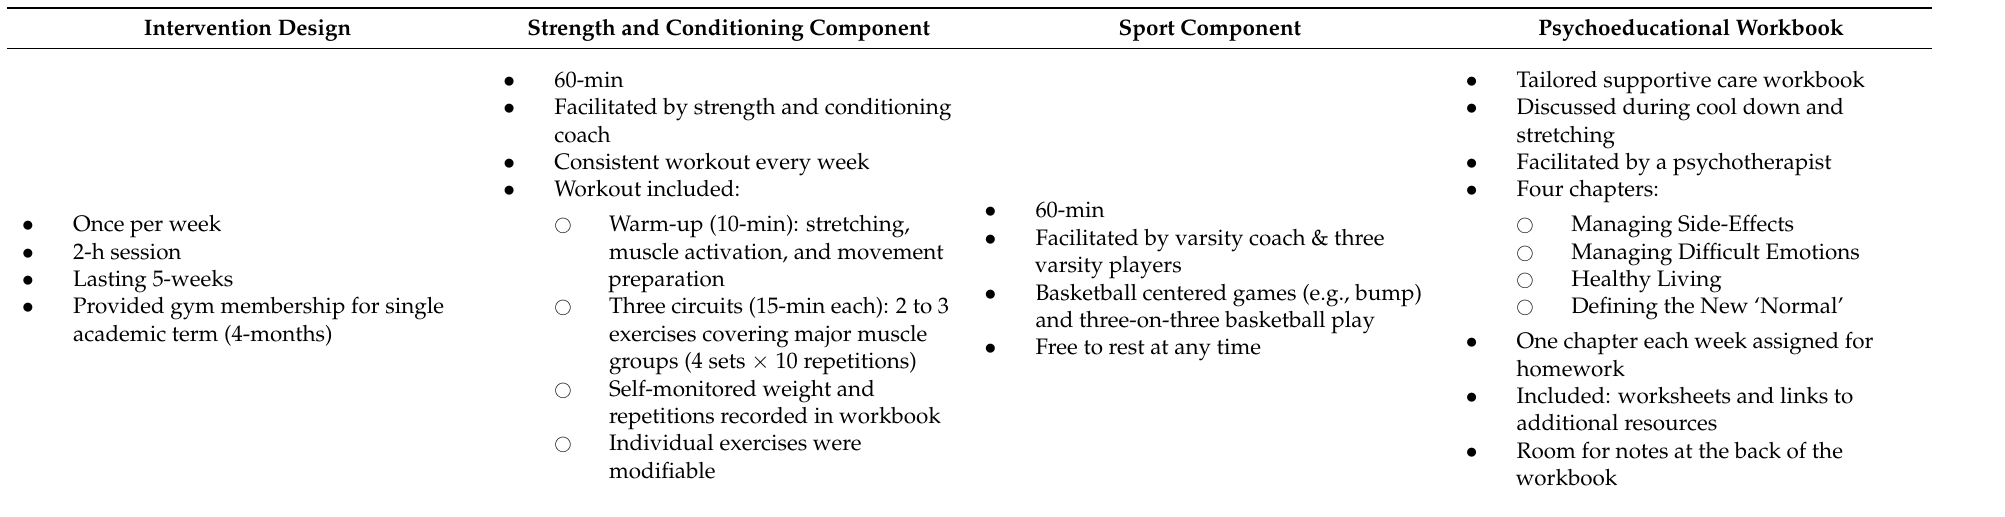
Table 1. The Ball’s in Your Court intervention